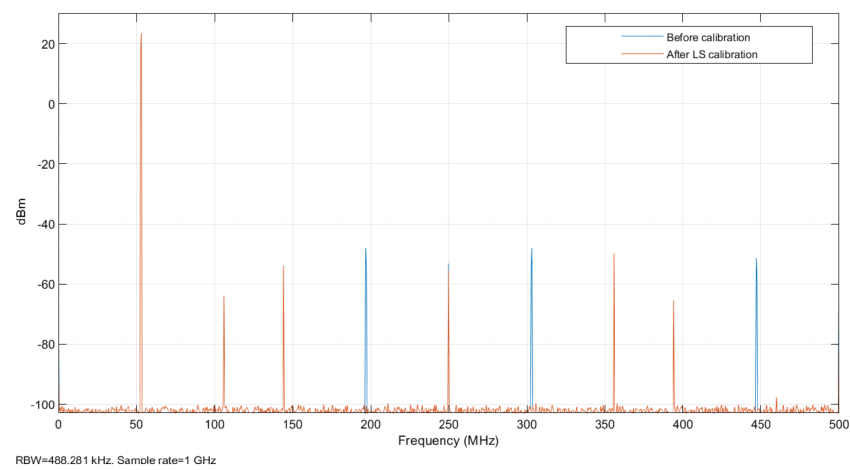
Figure 8. Spectrum of the TIADC model with memory nonlinearity mismatch.